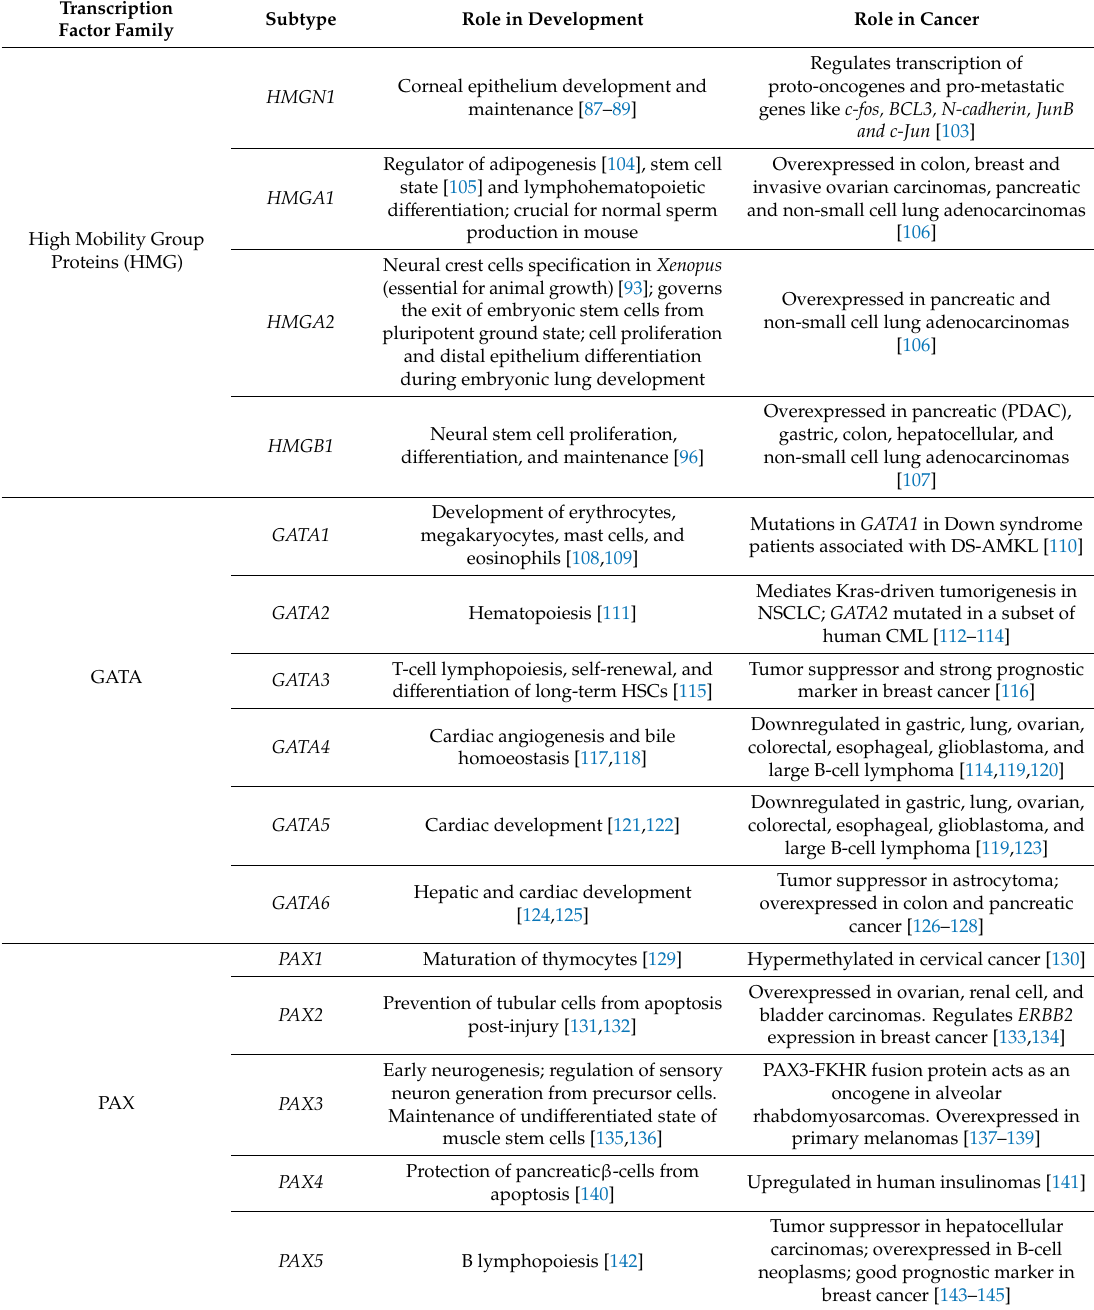
Table 1. The role of transcription factors in embryonic development and